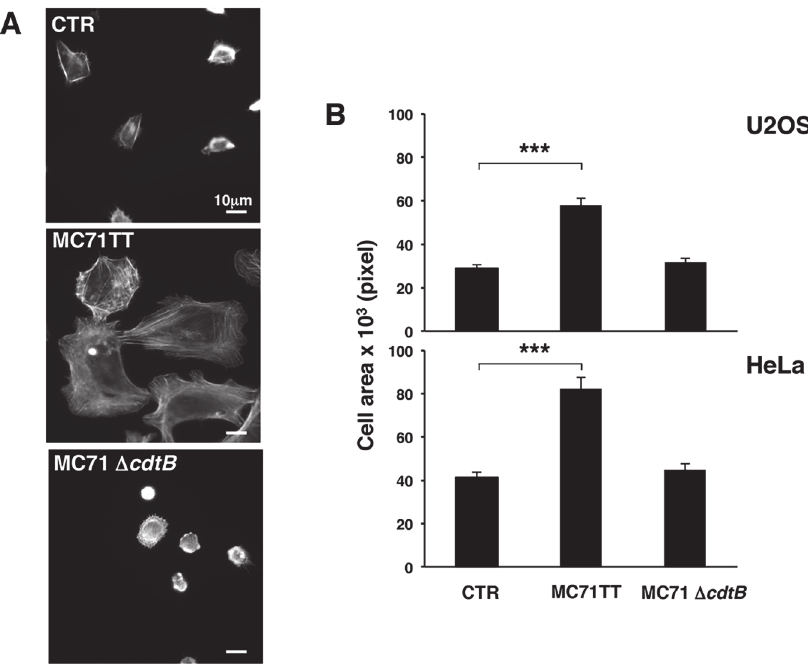
Fig 3. Infection with toxingenic S . typhimurium promotes cell spreading. A. U2OS cells were left untreated or infected for 24h with the S . typhimurium strains carrying the active typhoid toxin (MC71TT) or an isogenic strain carrying a deletion mutant of the active subunit, thus lacking the genotoxic activity (MC71 Δ cdtB ). Cells were detached with 2.5 mM EDTA in PBS, seeded on fibronectin-coated glasses for 20 minutes, prior fixation and immunofluorescence analysis. The actin cytoskeleton was visualized by phalloidin staining. B. Quantification of cell spreading of U2OS or HeLa cells left untreated or infected, as described in Fig 1. The area of 50 adherent cells per experiment was measured using the ImageJ software. The data are presented as the mean ± SEM of three independent experiments. Statistical analysis was performed using the Student t-test. *** p value <